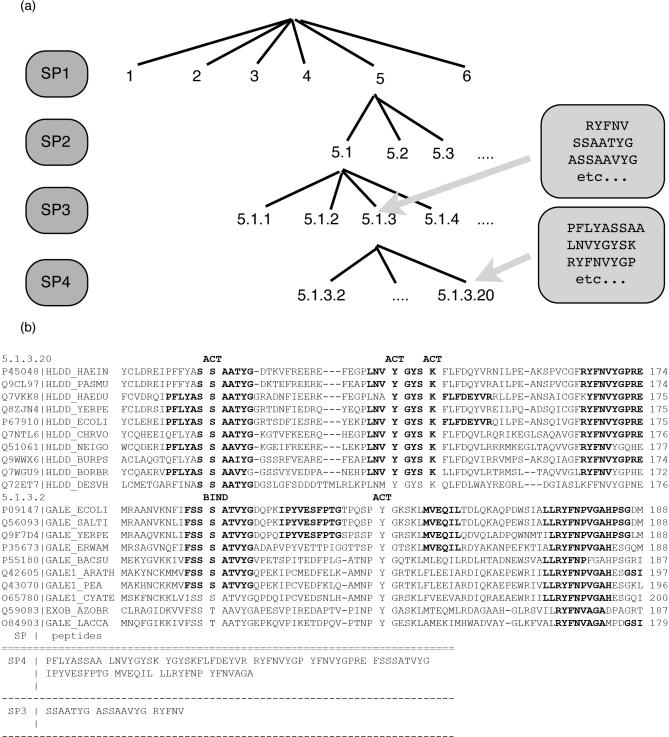
The Occurrence of Specific Peptides within the EC Hierarchy of Enzymes(A) A sketch of the EC hierarchy and the assignments of SPs to SP classes. SPs can be compared with those appearing in Figure 1B.(B) Aligned sequences of two groups of enzymes of level 4 that share the same third-level assignment. Alignment is performed according to SPs. The organisms in the upper group, 5.1.3.20, belong to proteobacteria, while those of the lower group, 5.1.3.2, also contain eukaryotes (ARATH, CYATE, and PEA). Boldfaced substrings denote SPs. Amino acids flanked by spaces denote active sites and binding sites, as indicated above. A list of all SPs and their assignments to SPN classes is presented below the sequences.